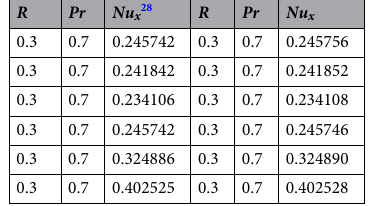
Table 2. Numerical outcomes for Nusselt